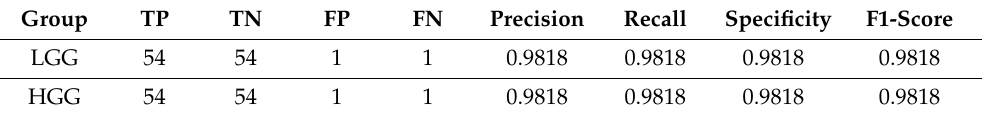
Table 2. Evaluation metrics’ precision, recall, specificity, and sensitivity for the DNN model where the connectivity matrix was used as an image is shown (values are given up to four decimal places to track even slight differences in the model’s performance).